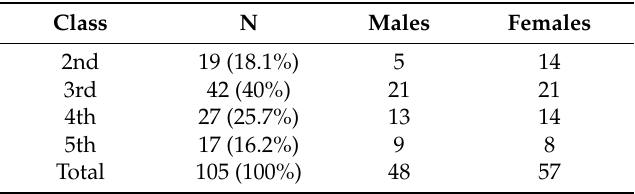
Table 1. Participants’ sociodemographic characteristics.